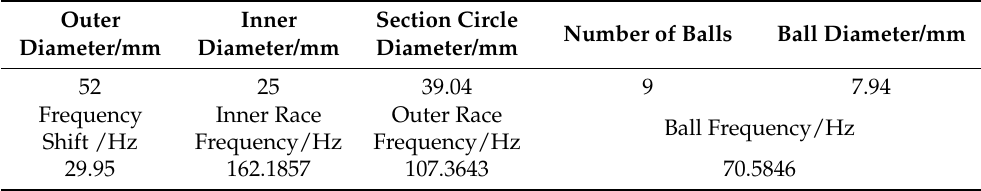
Figure 3. Time - frequency domain waveforms of vibration acceleration signal and spectrums of Figure 3. Time-frequency domain waveforms of vibration acceleration signal and spectrums of rolling bearing under ten kinds of work conditions. ( a )Time domain waveforms under 10 condi- rolling bearing under ten kinds of work conditions. ( a ) Time domain waveforms under 10 conditions; tions; ( b ) spectrums under 10 conditions. ( b ) spectrums under 10 conditions. Table 2. The 6205 bearing parameters and failure frequency.